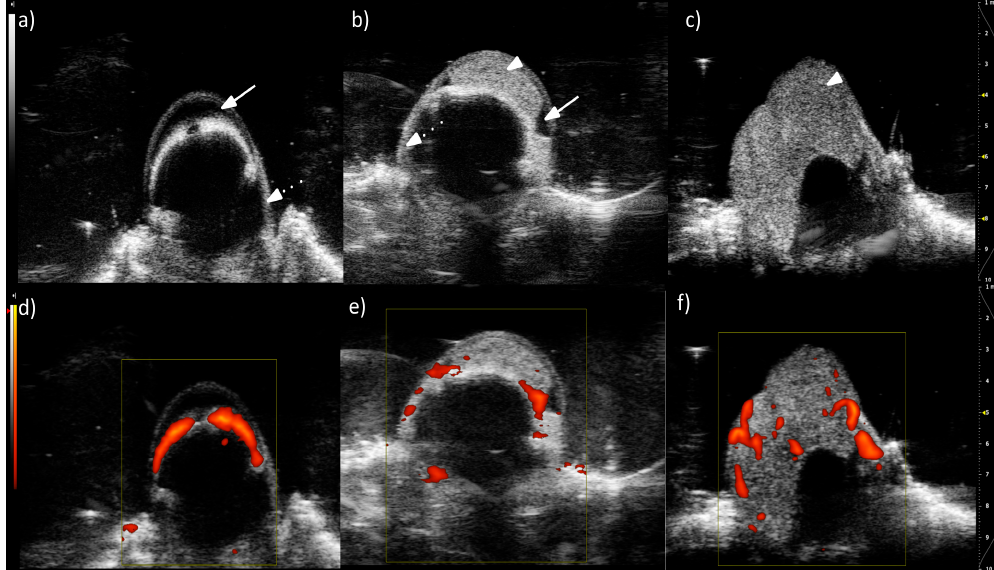
Figure 4. Single cross-section from 3D US images of the tumor in the eye of a living hamster. B-mode images showing a control eyeball ( a ); eyeball with a medium-sized tumor ( b ); and large tumor ( c ). Visible structures of the eye are indicated: anterior chamber (solid arrow), choroid (dotted arrow), tumor mass (arrowhead). In the lower panel, the Doppler mode is presented, showing vascular blood flow (color) in a control eyeball ( d ); eyeball with a medium-sized tumor ( e ); and large tumor ( f ). All colored areas correspond to blood flow. Darker colors indicate lower frequency signals. Scale on the right is in mm.